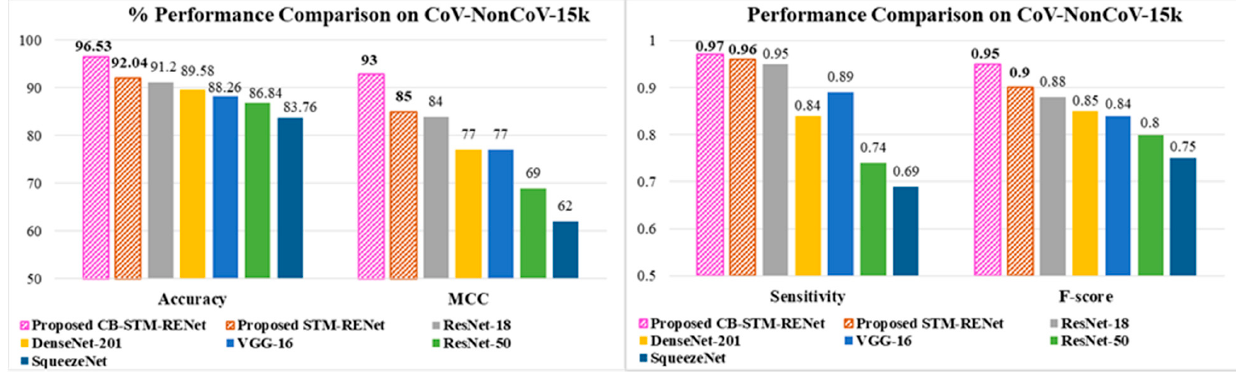
Figure 8. Performance comparison of the proposed CB-STM-RENet and STM-RENet with the well-established models.